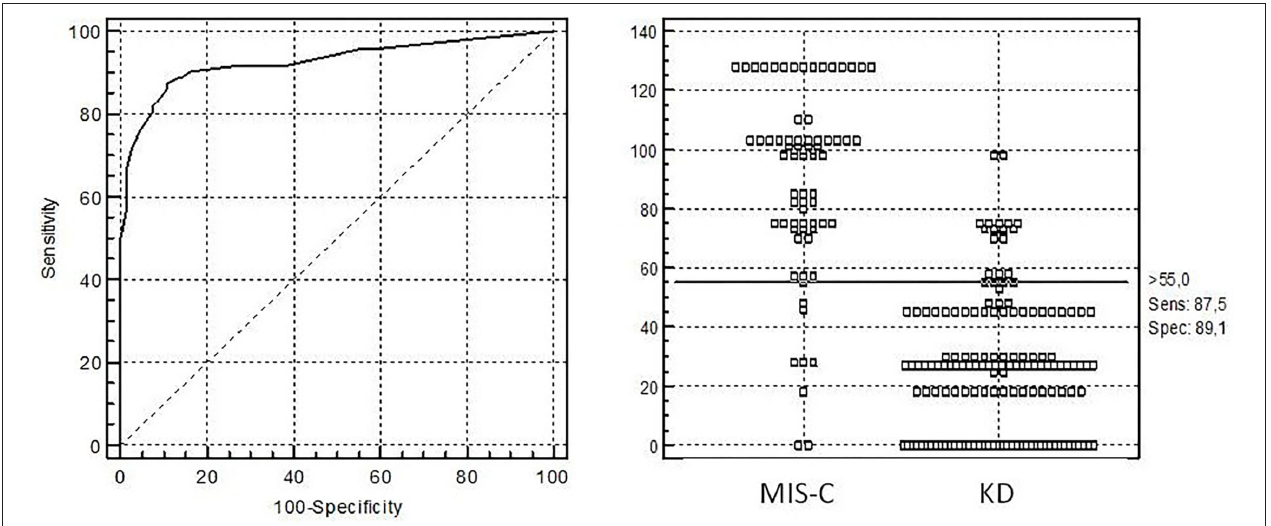
FIGURE 1 | Receiver operating characteristic (ROC) curve analysis for diagnosis of multisystem inflammatory syndrome in children with diagnostic score (KMDscore) computed with the developmental data set. The optimal cutoff was selected as the threshold giving the highest value for the sum of sensitivity and specificity. Area under the curve (AUC) = 0.927 (0.884–0.958), DS for MIS-C > 55 points with sensitivity of 87.5% and specificity of 89.1%.